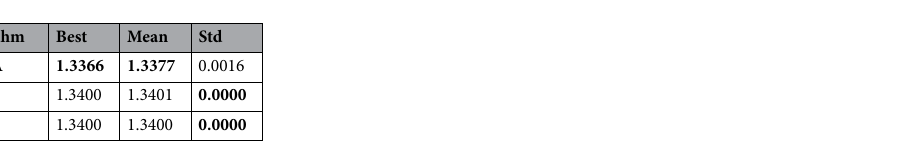
Table 18. Comparative results of LFGOA with other methods for cantilever beam design. The best of the comparison results are in [bold].